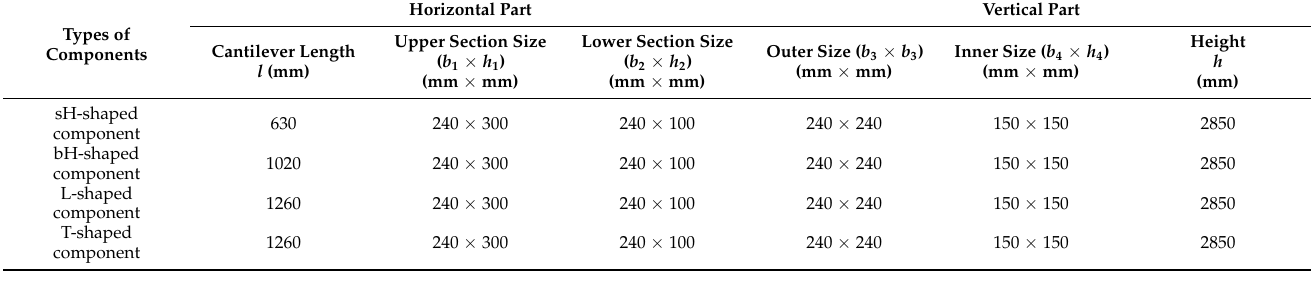
Table 2. Dimensions of prefabricated cantilever components.